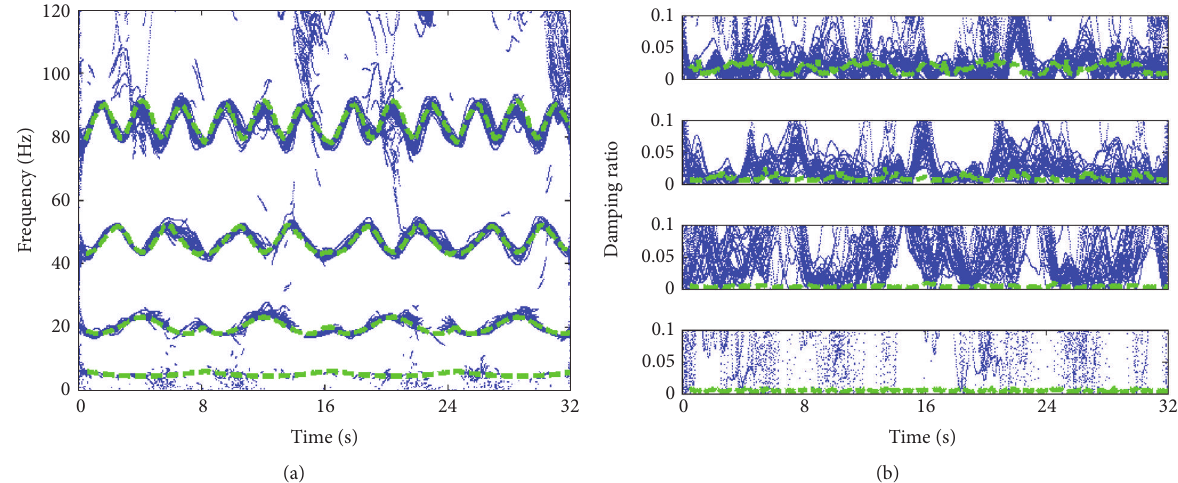
Figure 12: RPLR-FS-TARMA based modal parameter Monte Carlo estimates (30 realizations): (a) natural frequency estimates and (b) damping ratio estimates.